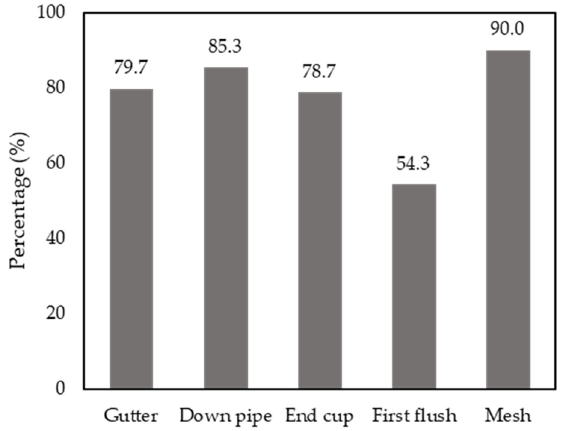
Figure 6. Presence of different components of the RWH system.